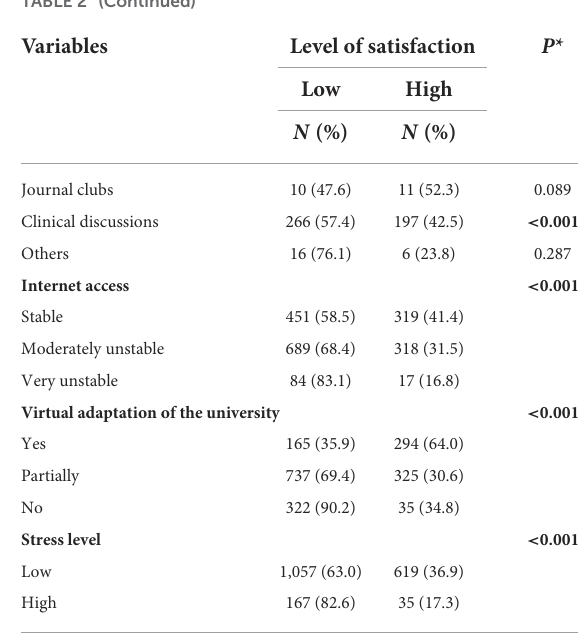
TABLE 2 Factors associated with the level of satisfaction with virtual education (bivariate